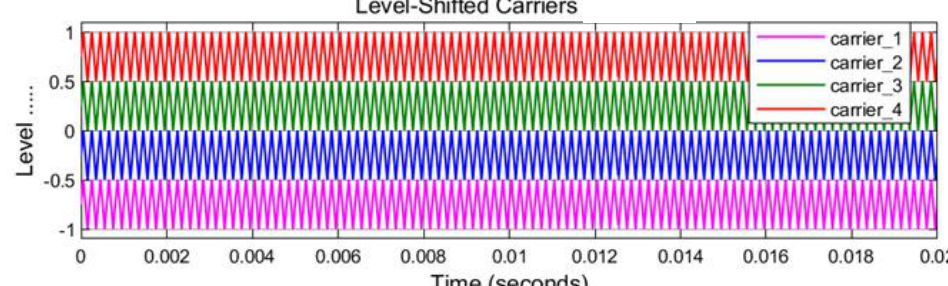
Figure 16. Simulation result of four level-shifted carriers using DSA-LSC method.